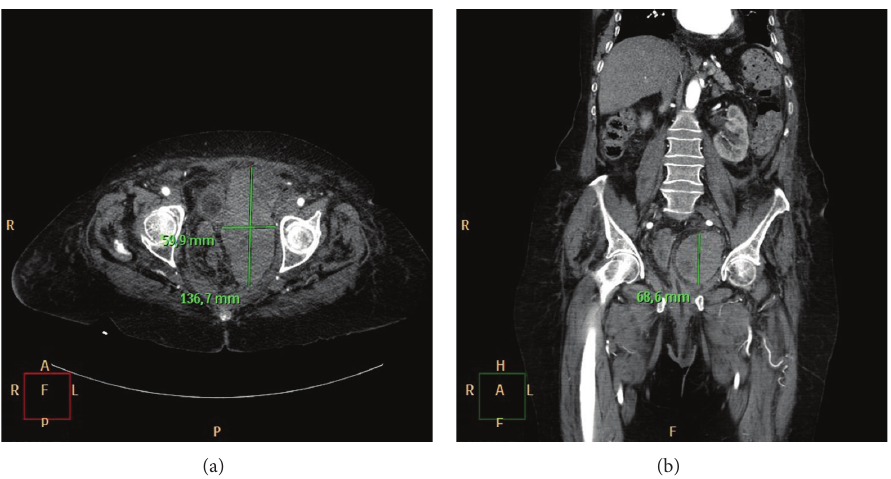
Figure 3: Axial (a) and coronal (b) CT of the pelvis demonstrating the size of pelvic